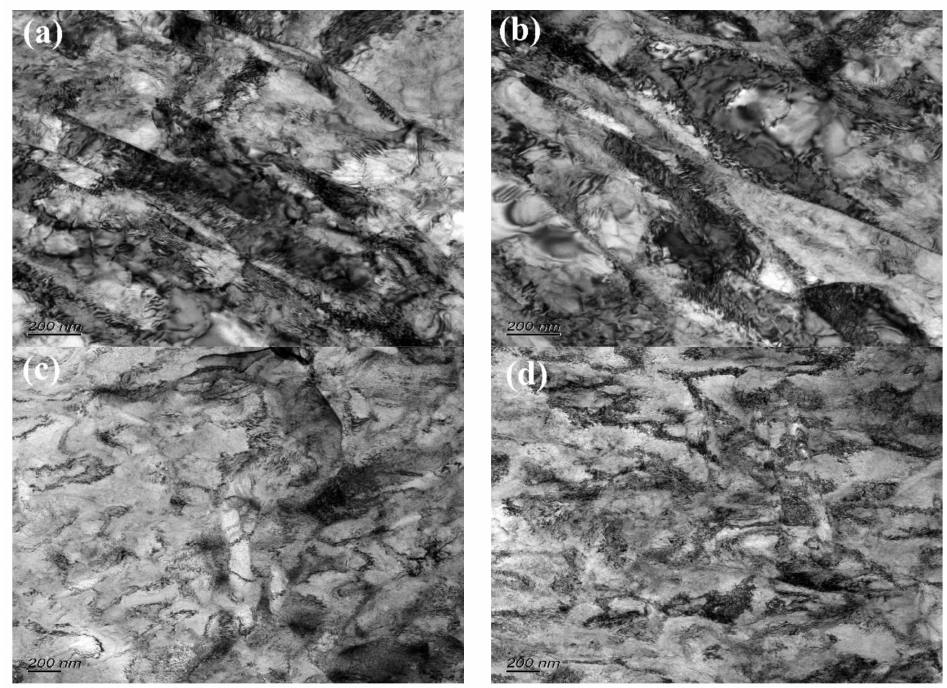
Figure 8. Transmission electron microscope (TEM) images of the forged ( a , b ) SP700 and ( c , d ) SP700Cr alloys after tensile experiment at 770 ◦